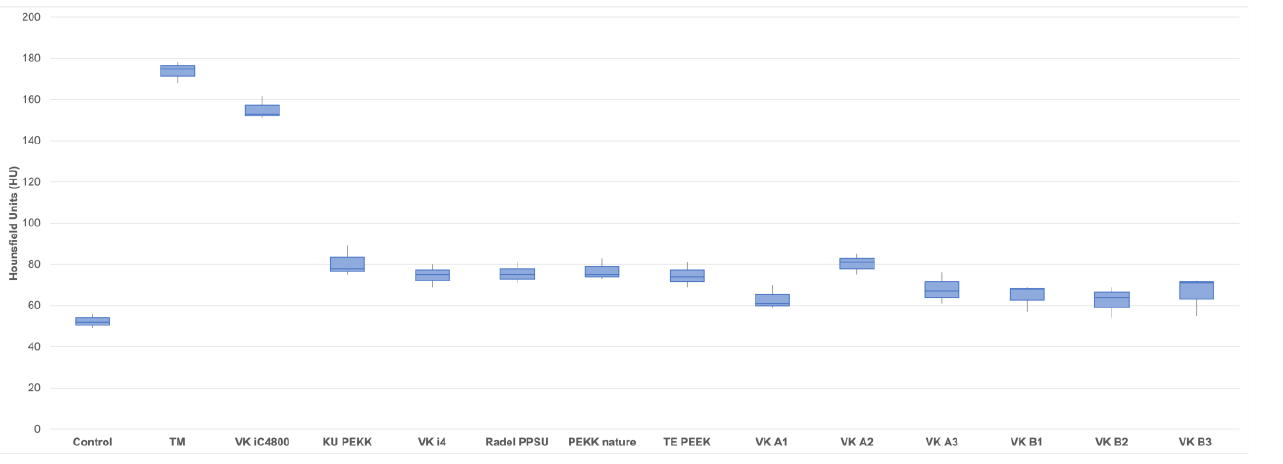
Figure 6. Streak artifacts VK A1, VK A2, VK A3, VK B1, VK B2 and VK B3 in CT images in axial orientation versus control. Artifacts of each implant were measured at three different anatomical landmarks: (1) the zygomatic soft tissue, (2) the temporal muscle and (3) the parotid gland.